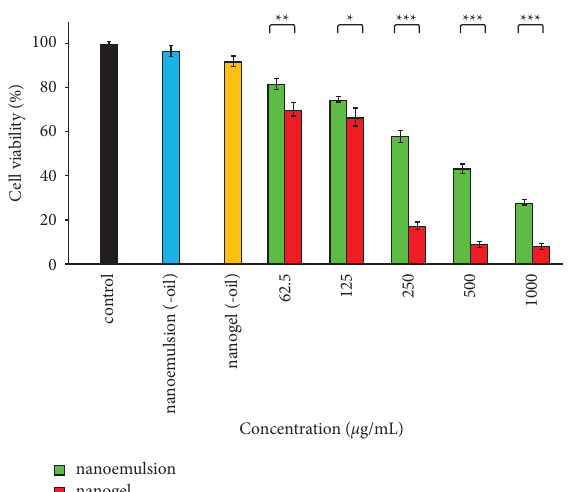
Figure 5: Cytotoxic impacts of the nanoemulsion and nanogel containing C . cyminum EO against A-375 cells. ∗ P < 0 . 05, ∗∗ P < 0 . 01, and ∗∗∗ P < 0 . 001.